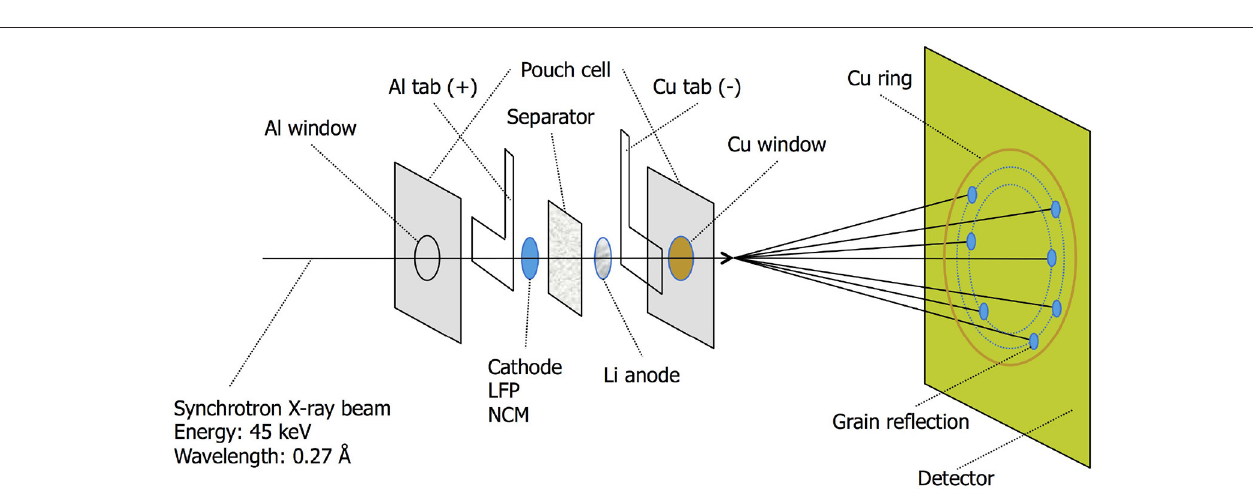
Frontiers in Energy Research |